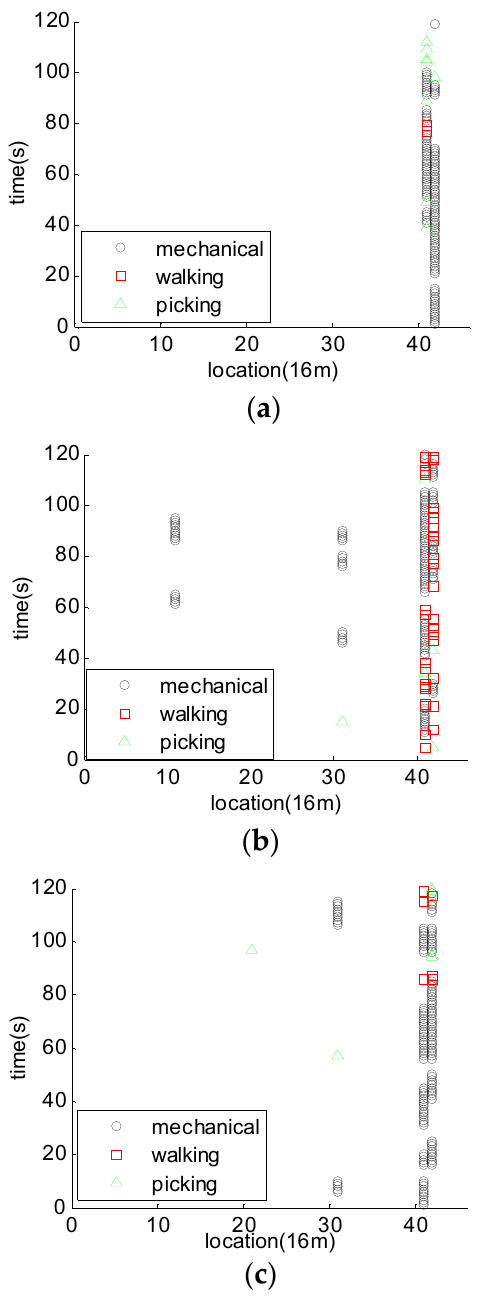
Figure 14. The identification results of mechanical picking signals. ( a ) The first group of mechanical picking signals; ( b ) The second group of mechanical picking signals; ( c ) The third group of mechanical picking signals. Table 1. The statistical identification results of Mechanical drilling signals.